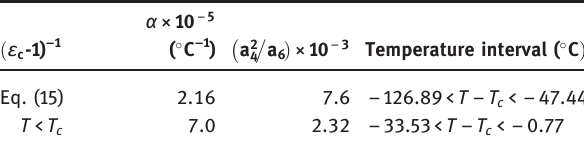
Table 2: Values of the coefficients for the dielectric constant ε c at various temperatures according to eq. (15) in the ferroelectric phase ( T < T c ) of TMAHSO 4 using the experimental data [1] within the tem- perature intervals indicated.